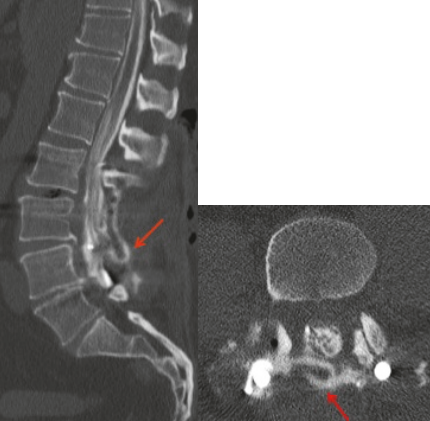
Figure 1: Sagittal and axial CT lumbar myelogram images show a focal CSF leak from the posterolateral aspect of the thecal sac at L3-L4 level, with iodinated contrast accumulating posterior to the thecal sac (red arrows).